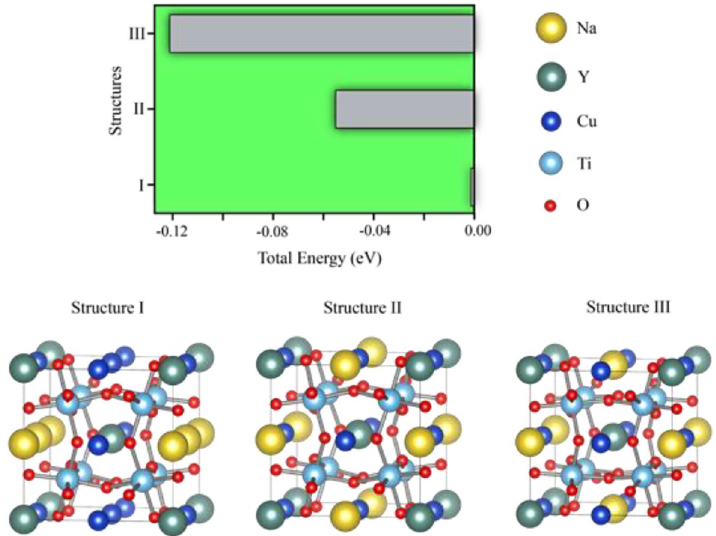
Figure 12. Total energy of three different configurations of Na and Y atoms in the CCTO lattice.